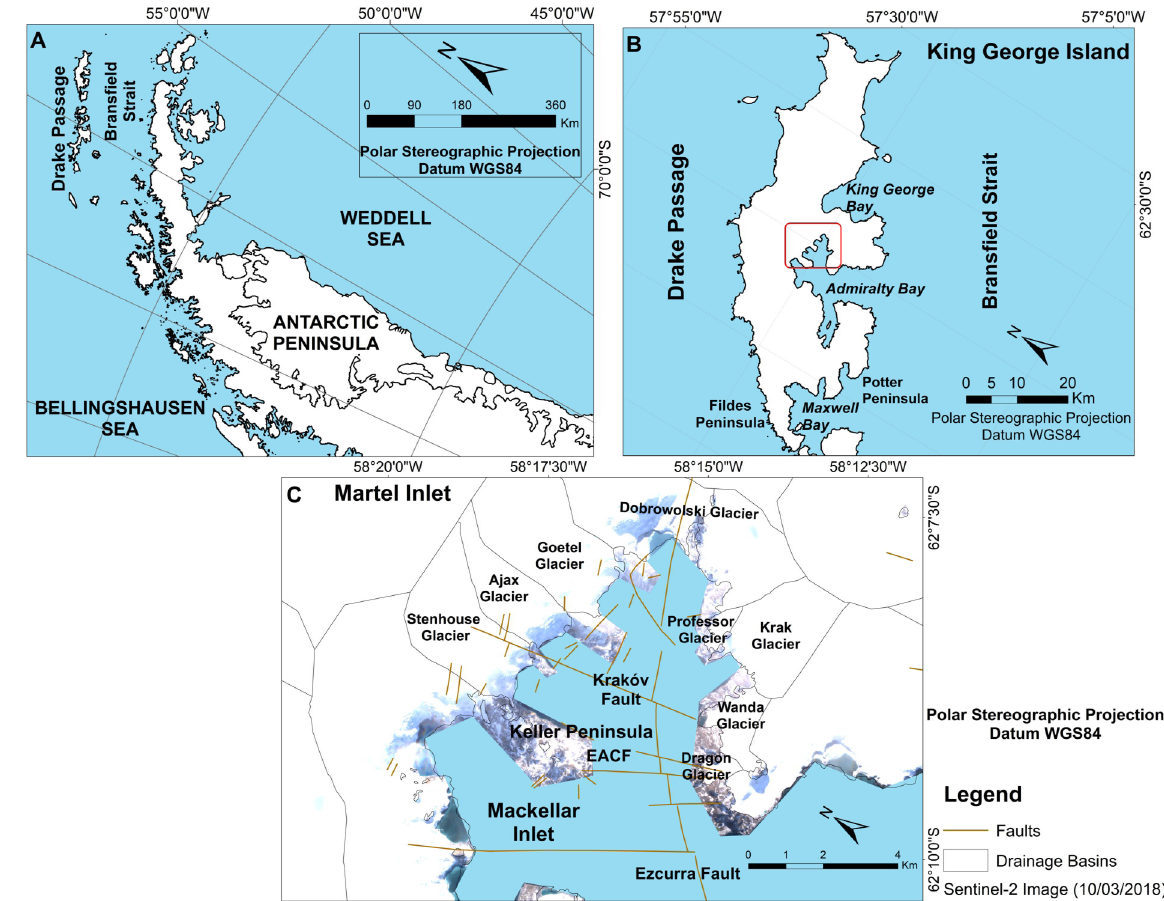
Figure 1. Location map. a) KGI location northeast of the Antarctic Peninsula. b) Location of Martel Inlet (MI) on King George Island. c) MI and the current glaciers. Comandante Ferraz Antarctic Station (EACF). Data source: Quantarctica (Matsuoka et al.